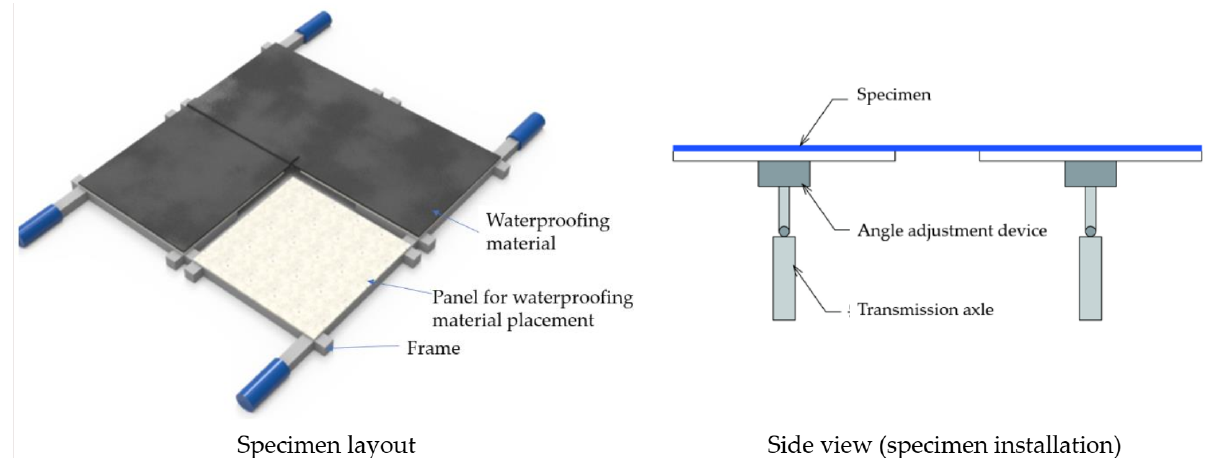
Figure 10. Schematic diagram of 3-axis driving stress verification of rotation, speed, and